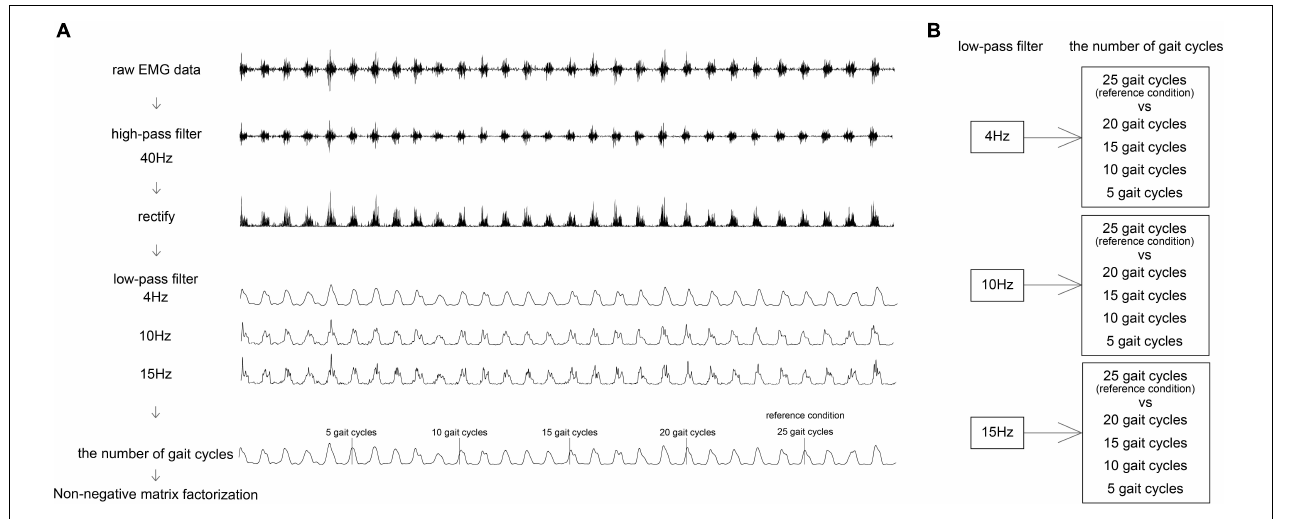
FIGURE 1 | A flowchart of pre-processing for NNMF. Algorithm (A) and condition setting (B) . (A) Pre-processing of one muscle. NNMF, non-negative matrix factorization.